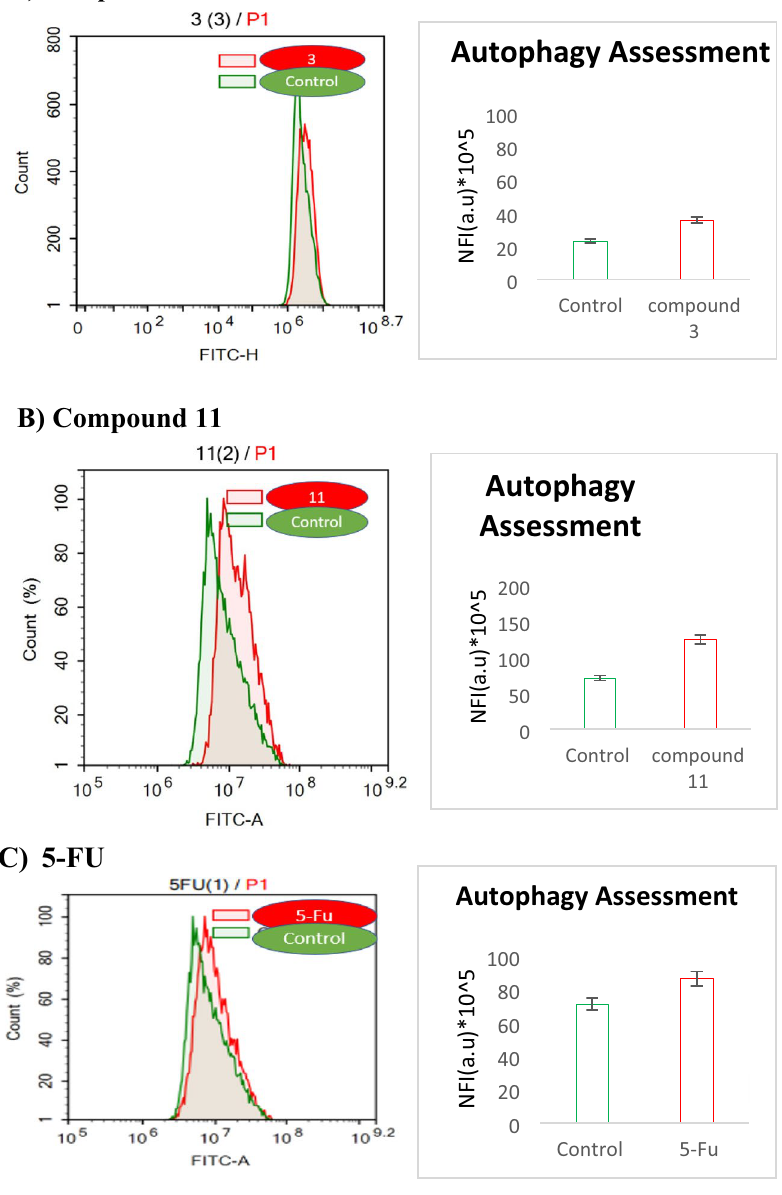
Figure 8. Autophagy assessment for compounds 3 , 11 and 5-FU on HCT-116 cells; ( A ), ( B ), and ( C ),